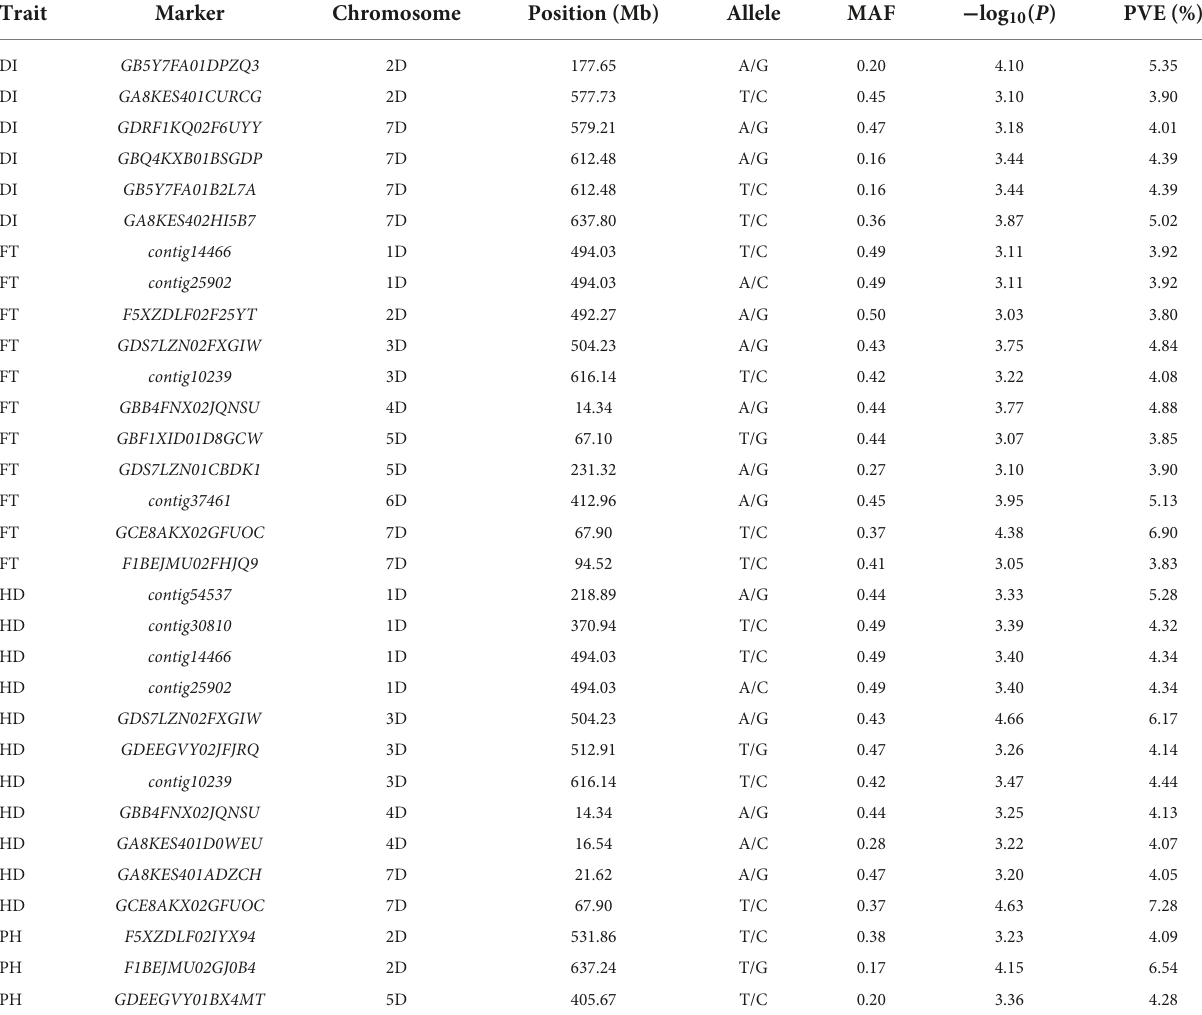
TABLE 3 Significant markers associated with disease index, flowering time, heading date, and plant height.